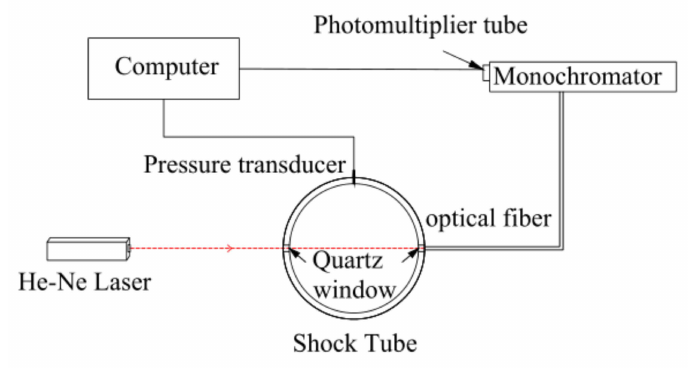
Figure 4. Schematic setup for measurement of soot extinction.